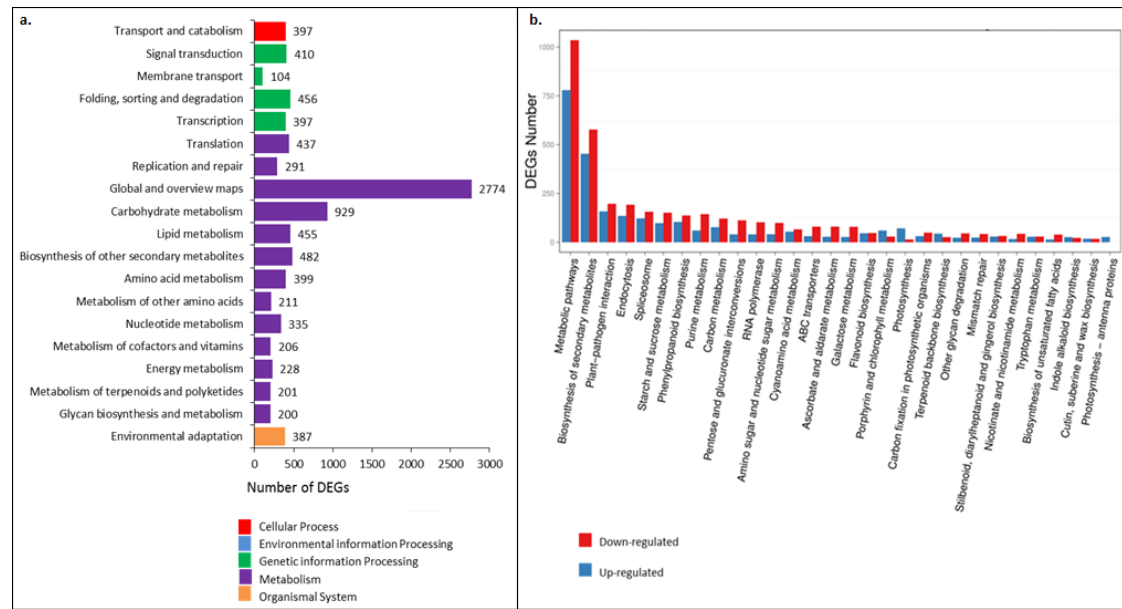
Figure 5. KEGG pathway analysis of comparative data between single and double flower species. ( a ) KEGG Pathway enrichment of DEGs involved in different processes. ( b ) Trend of regulation of highly enriched-pathways in differentially expressed genes between single and double flowered species of apple.